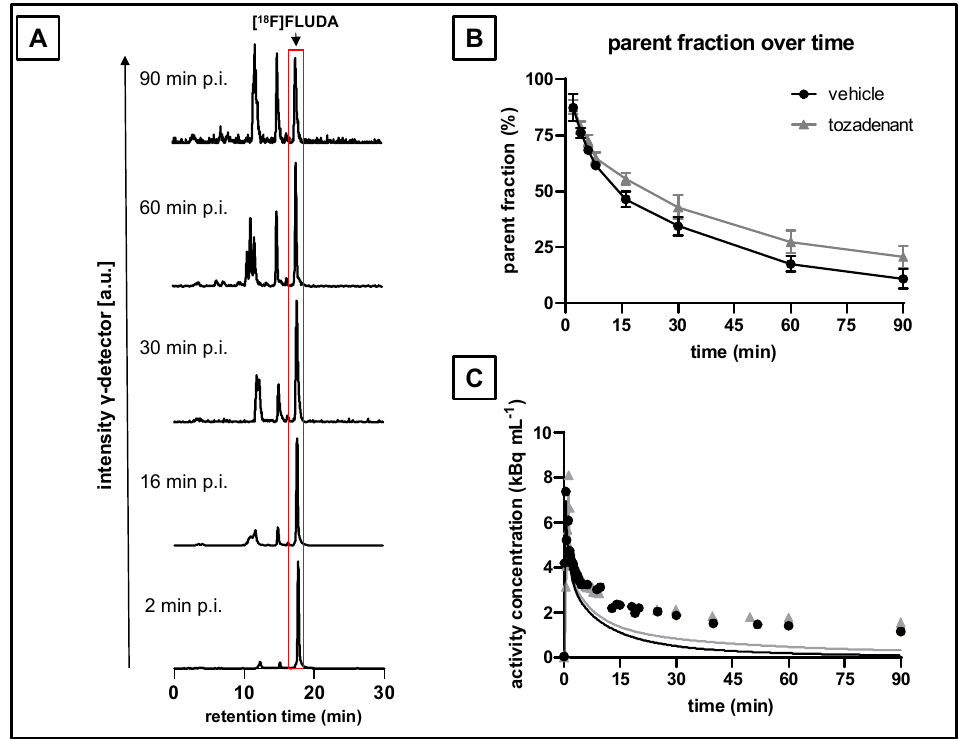
Figure 4. Determination of parent and radiometabolite fractions of [ 18 F]FLUDA in plasma samples of pigs and the metabolite–corrected arterial input function. ( A ) Representative RP–HPLC radio–chromatograms of plasma extracts from blood samples collected after IV administration of [ 18 F]FLUDA in pigs, ( B ) mean parent fractions in control and tozadenant–treated animals ( n = 3, mean ± SD), and ( C ) total plasma activity (circles and triangles) and the corresponding metabolite– corrected, bi–exponentially fitted plasma input functions (lines) from representative pigs with (grey) or without (black) tozadenant (bolus + infusion) treatment.